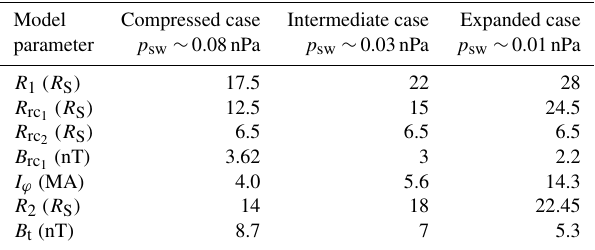
Table 1. Paraboloid model parameter sets for compressed, interme- diate, and expanded Saturn magnetospheric states, following Alex- eev et al. (2006) and Belenkaya et al. (2006b, 2008), together with the total current flowing in the ring current given by Eq. (2).